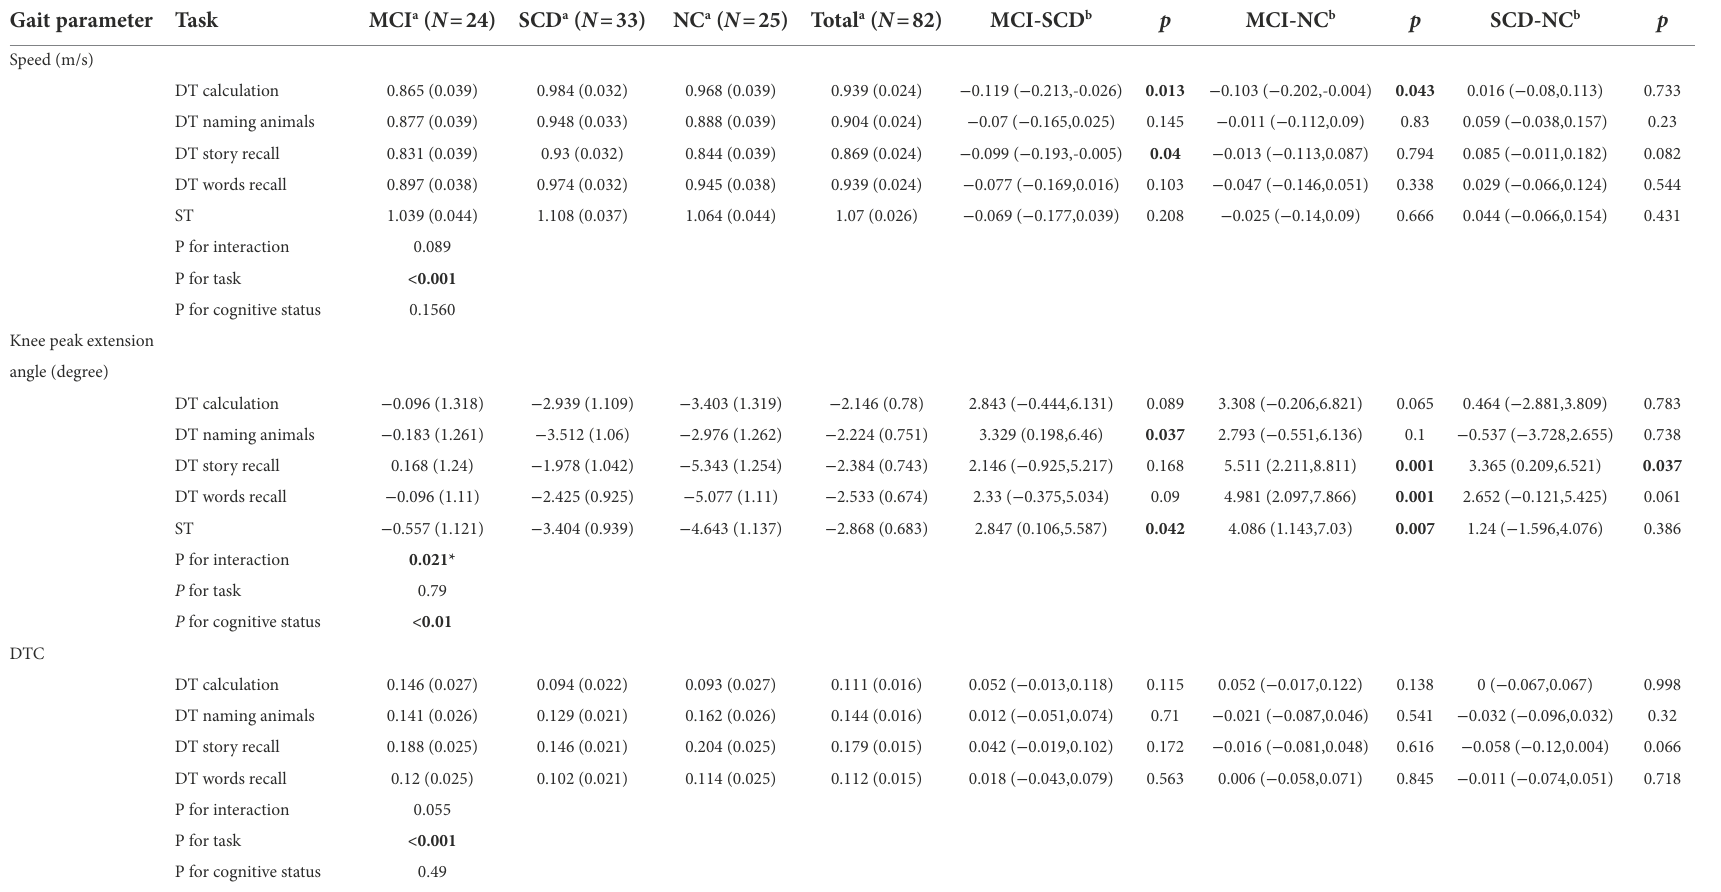
TABLE 2 The adjusted mean for speed, Knee extension angle, and DTC of different DT conditions and severity of cognitive disorder*. Gait parameter